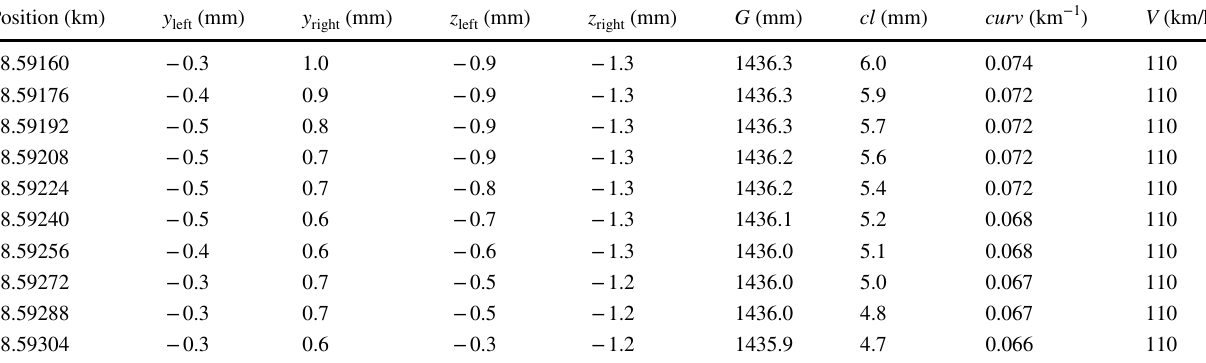
Table 1 The first ten observations from the data file used in this report